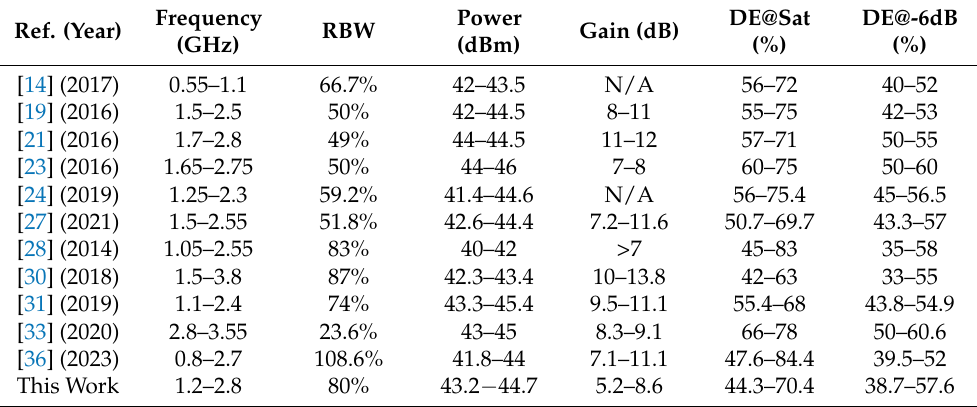
Table 1. Experimental results of the fabricated DPA and some previous state-of-the-art